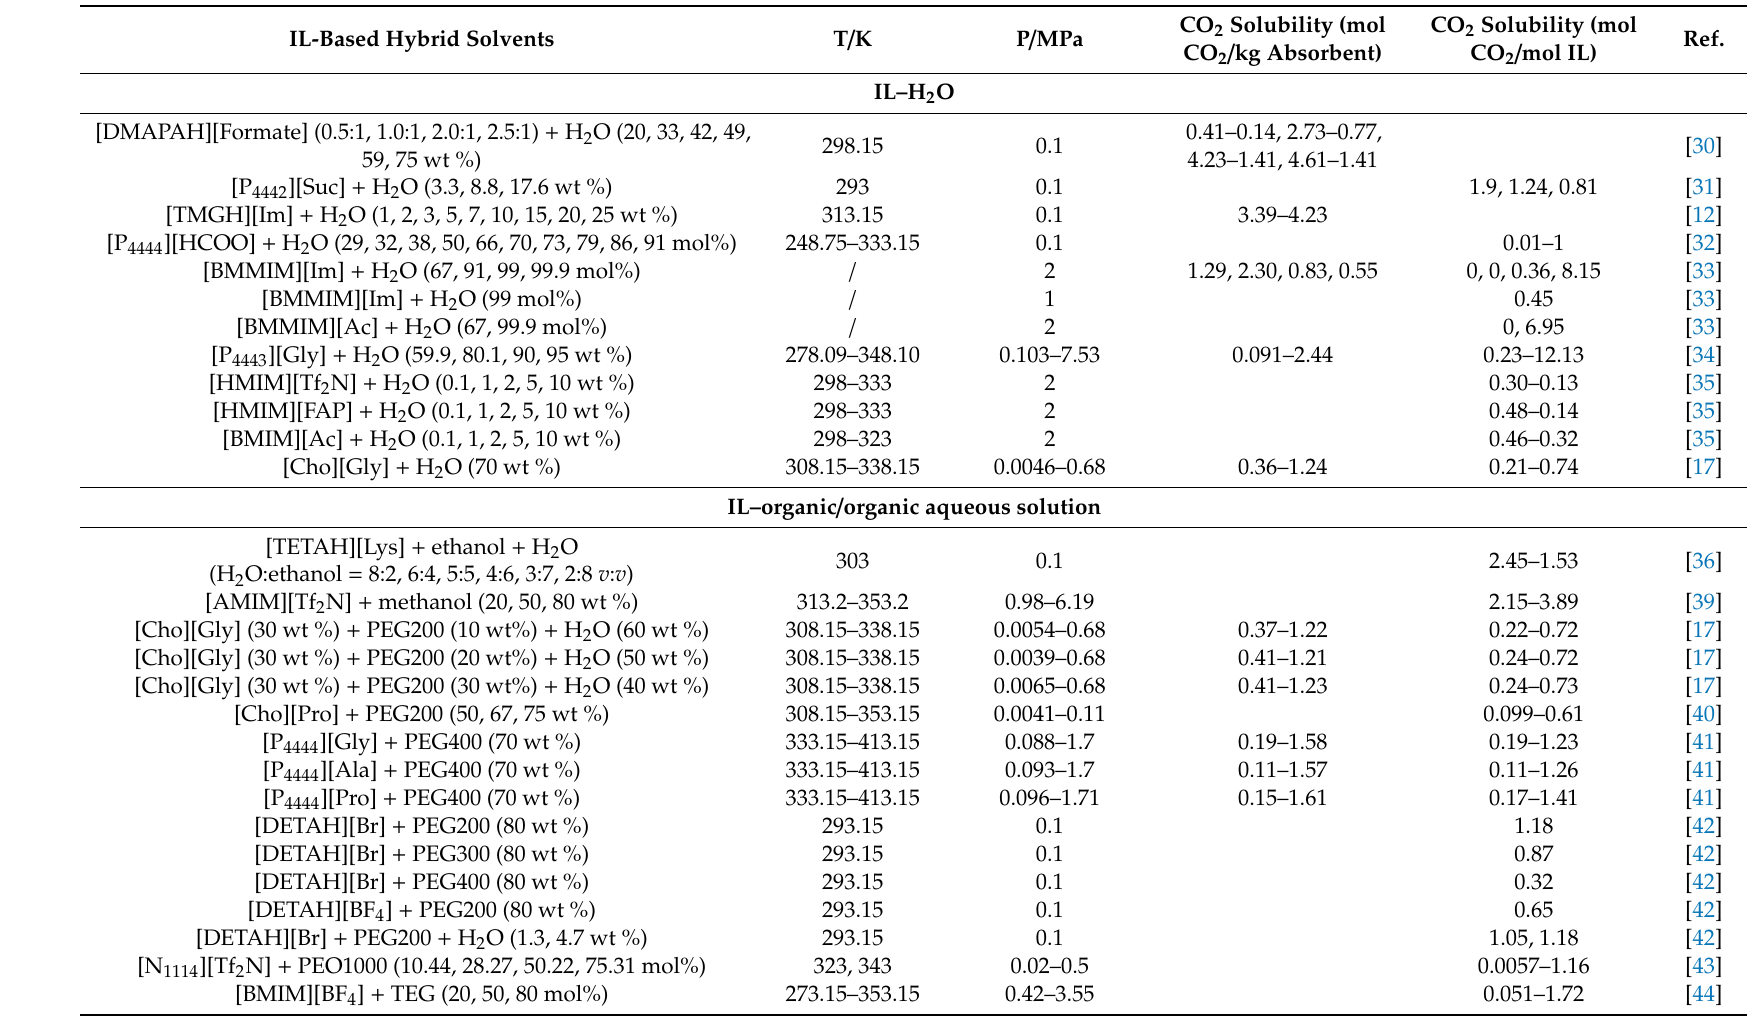
Table 1. CO 2 solubility of ionic liquid (IL)-based hybrid